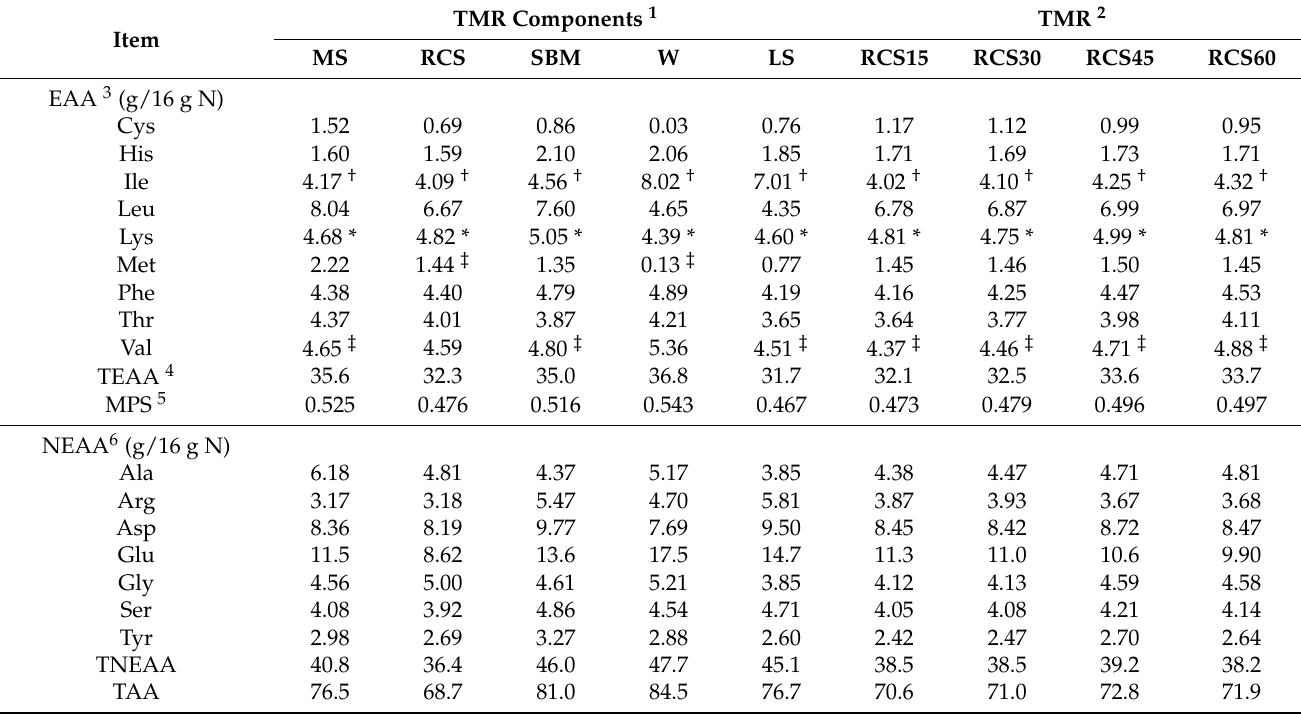
The AA content, the MPS, and the ranking of the three most limiting AAs relative to milk protein of the feed residues after 16 h of ruminal incubation of TMR and their individual components are shown in Table 3. The highest concentration of TAA in the feed residues was for wheat and SBM (84.5 and 81.0 g/16 g N) and the lowest for RCS (68.7 g/16 g N). Based on the MPS, Lys and Ile were the first and second most limiting AAs along all TMR diets and their individual ingredients. Methionine was the third limiting AA for RCS and wheat, and Val for MS, SBM, and lupine seed. Valine was the third most limiting AA for all TMR. The concentration of TAA in the feed residues of the TMR varied between 70.6 and 72.8 g/16 g N. Table 3. Concentration of amino acids (AAs) of feed residues of individual feeds and total mixed rations (TMR) after 16 h of ruminal